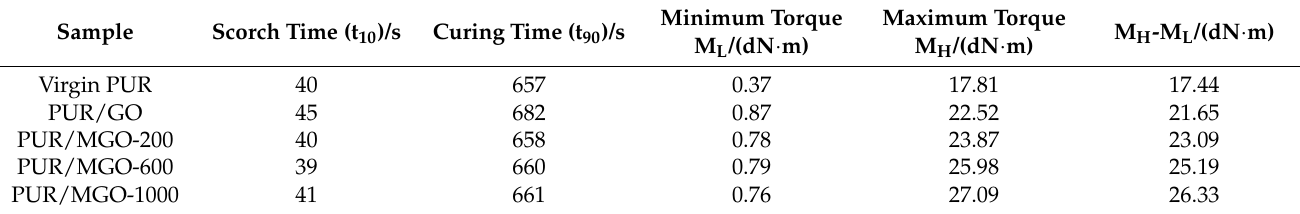
Table 2. Vulcanization properties of PUR, PUR/GO and